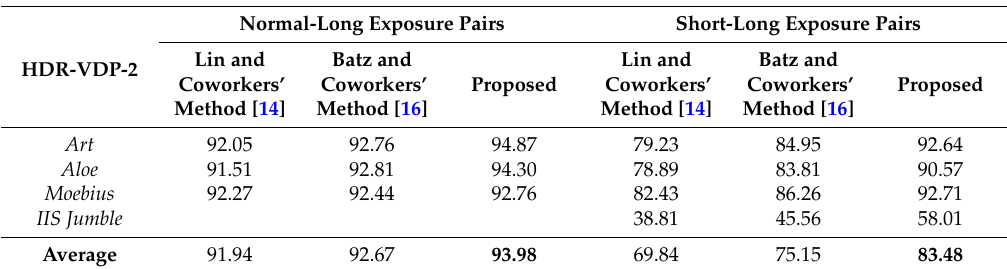
Figure 16. Resultant HDR visual difference predictor 2 (HDR-VDP2) maps for the Middlebury database with normal-long exposure: ( a ) Lin and coworkers’ method [14]; ( b ) Batz and coworkers’ method [16]; and ( c ) proposed method.